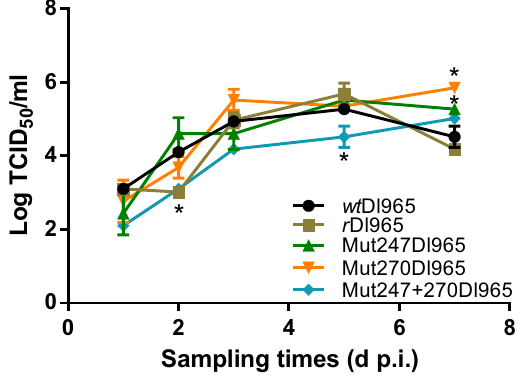
Figure 1. Viral replication on the E-11 cell line inoculated at 0.1 multiplicity of infection (MOI). The one- way ANOVA with Bonferroni’s multiple comparisons test were the statistical analyses carried out. Asterisk represents significant differences compared to wt Dl965 within each sampling time (p < 0.05). Results are mean ± standard deviation (s.d.) (n =